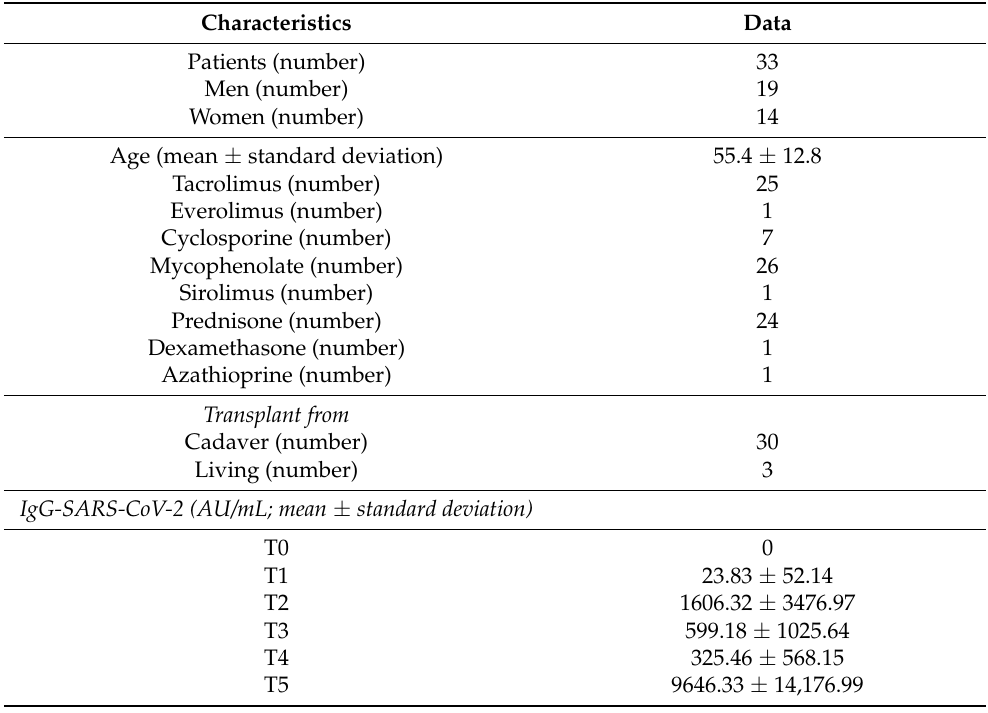
Table 1. The demographics of the patients enrolled in the study. T0: admission; T1: II dose of vaccine: 3 weeks after T0; T2: 2 months after T1; T3: 3 months after T2; T4: 6 months after T1, in this time, the patients underwent the III dose of vaccine; T5: 3 weeks after T4, end of the study. Characteristics Data Patients (number) 33 Men (number) 19 Women (number) 14 Age (mean ± standard deviation) 55.4 ± 12.8 Tacrolimus (number)